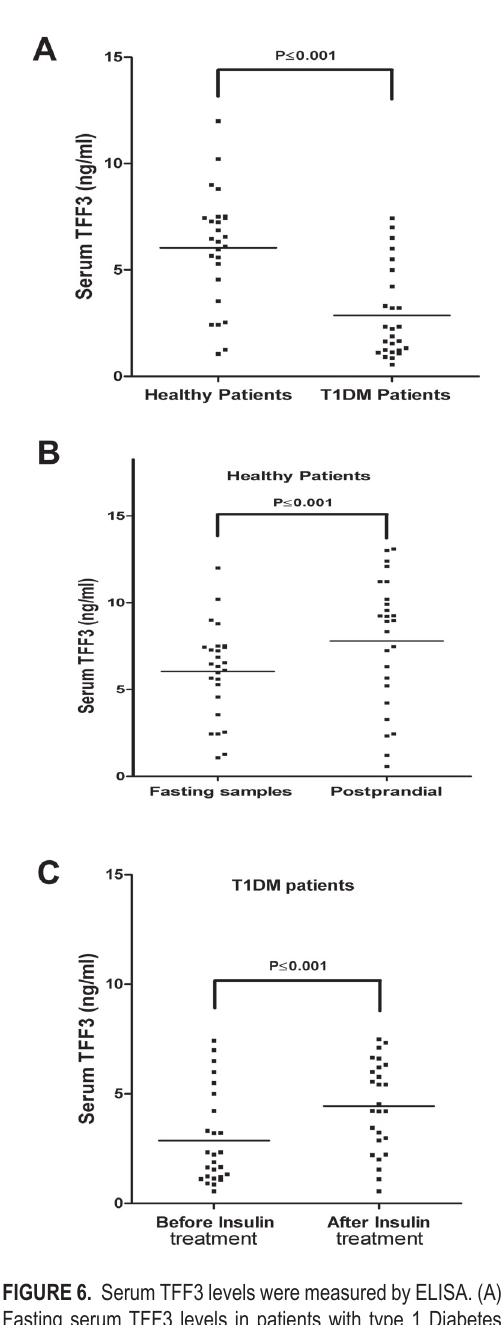
FIGURE 6. Serum TFF3 levels were measured by ELISA. (A) Fasting serum TFF3 levels in patients with type 1 Diabetes Mellitus were signi fi cantly lower than in the control group. (B) Serum TFF3 levels in the control group After 2-h postprandial period were also signi fi cantly higher than fasting serum. (C) Serum TFF3 levels in Type 1 Diabetes Mellitus Two hours af- ter treatment with insulin were signi fi cantly higher than fasting